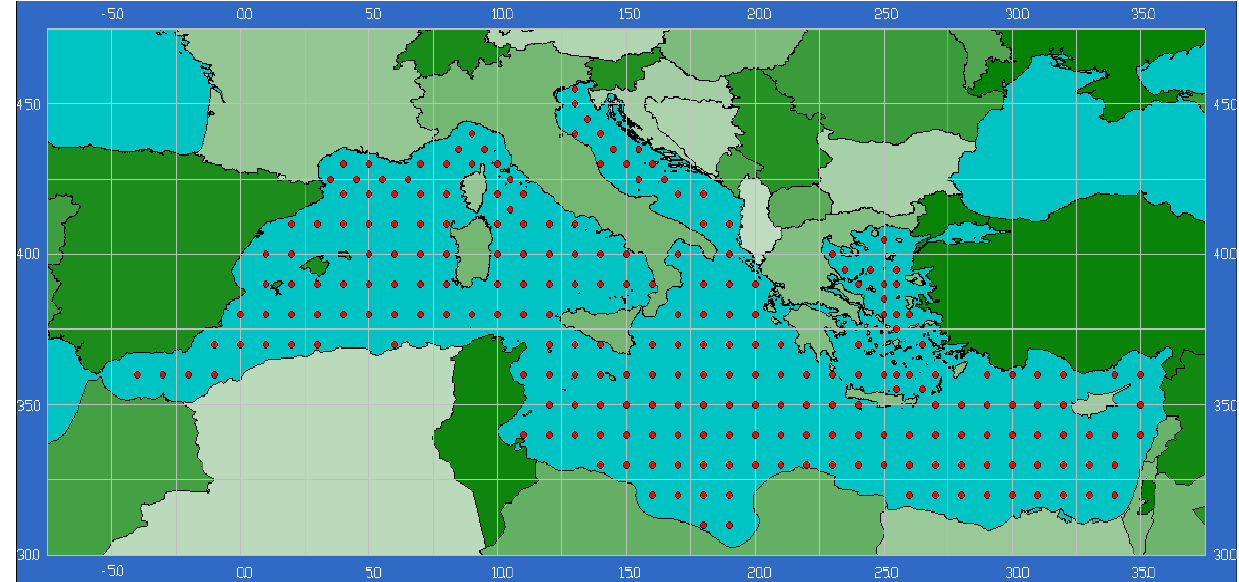
Figure 1. Map with points where the wave climate is available [15].